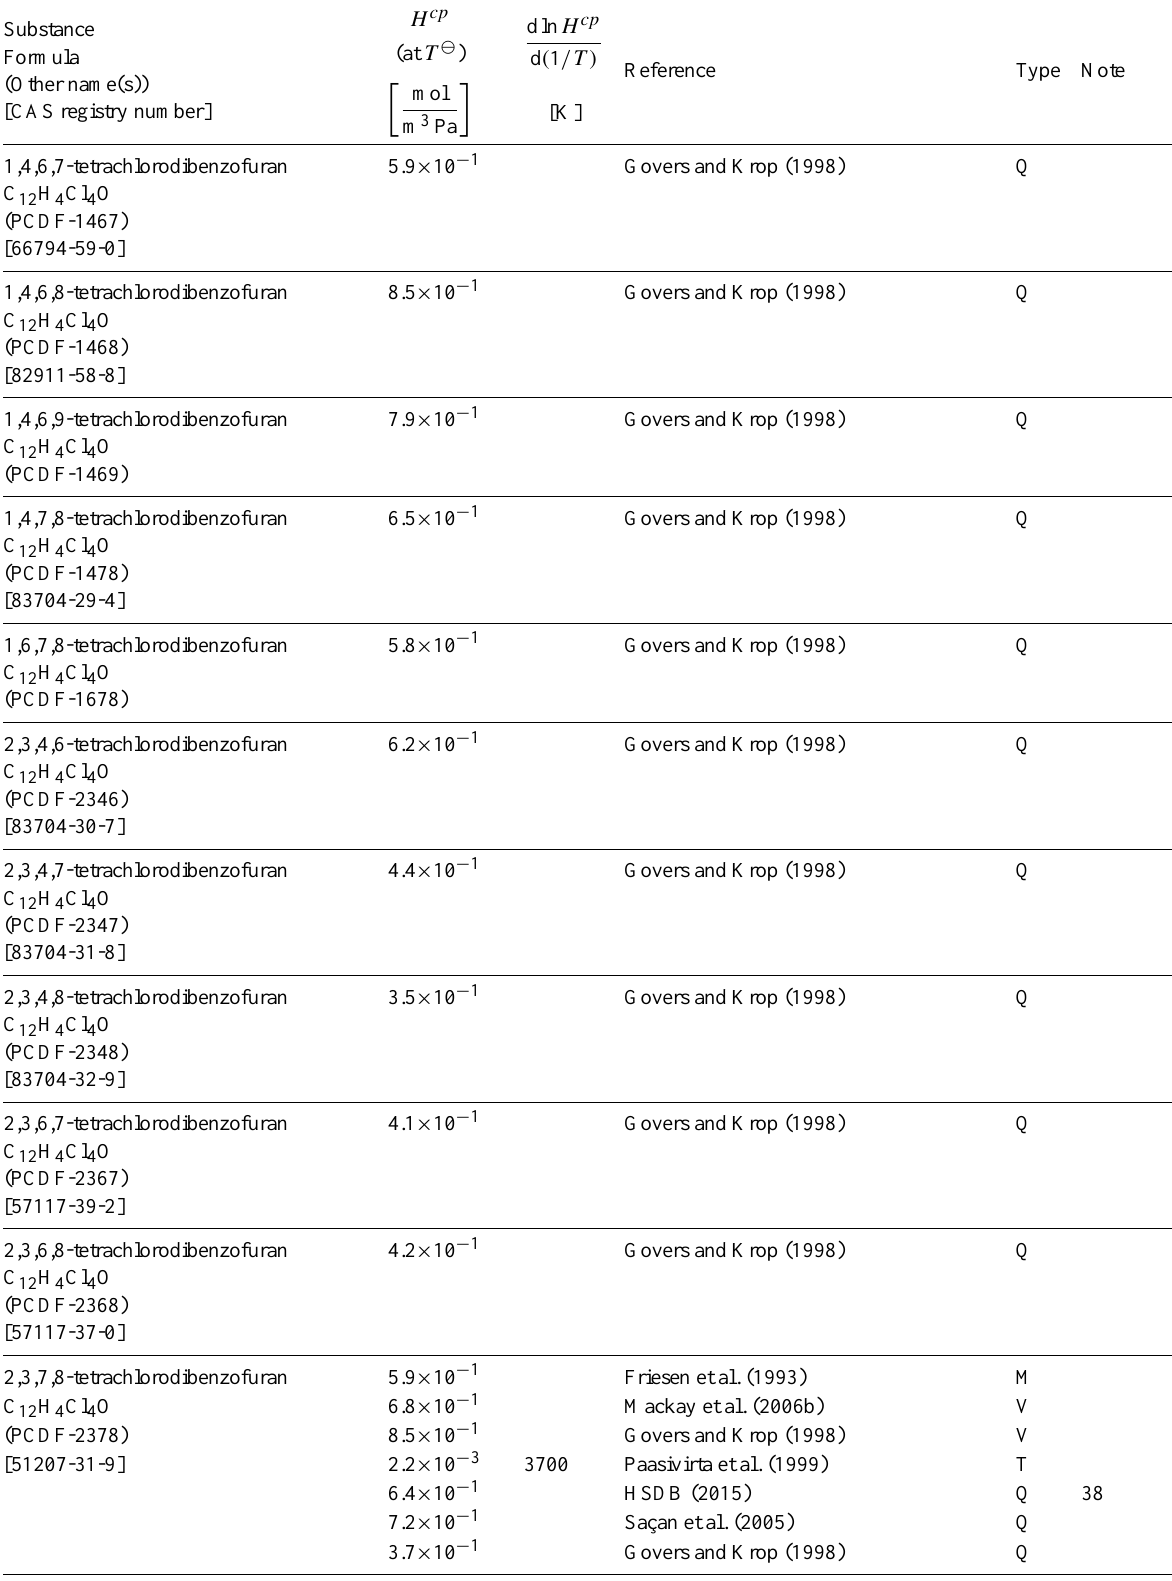
Table 6: Henry’s law constants for water as solvent